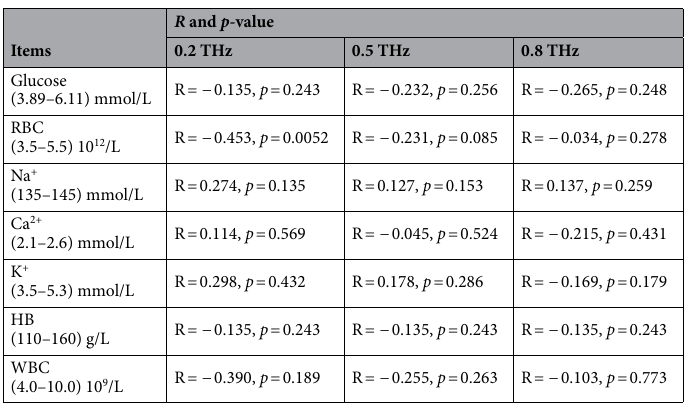
Table 2. Results of statistical analysis results summarizing the Pearson correlation coefficient and the p -value between the THz absorption and examination items. The range of each item is listed in parenthesis.